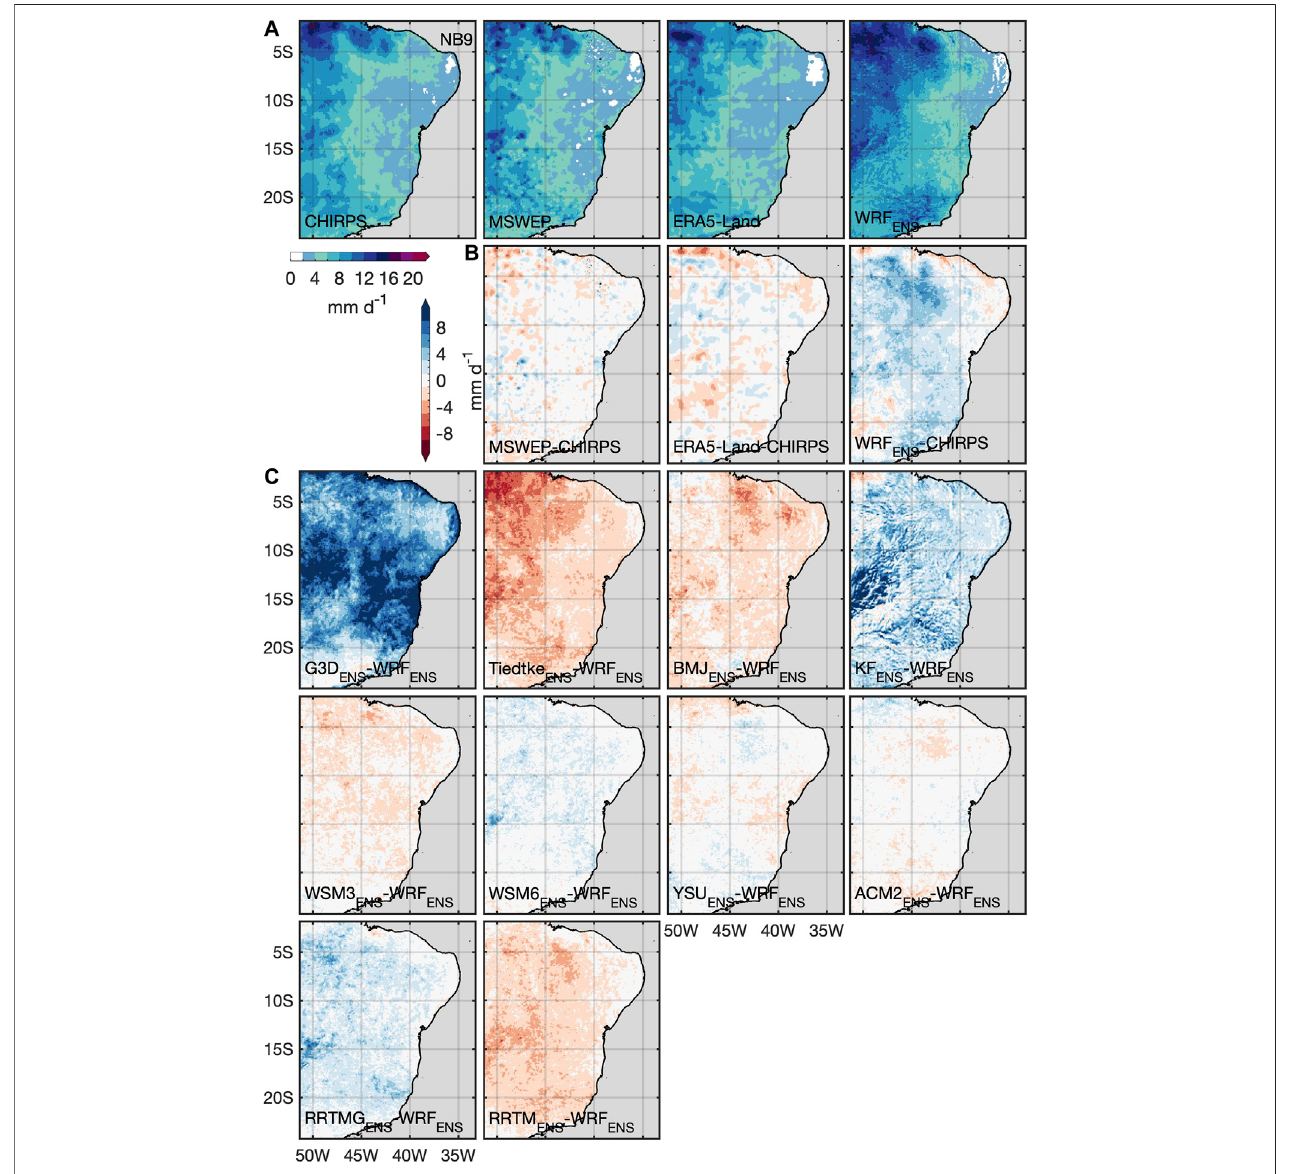
FIGURE 4 | As Figure 3 , but for